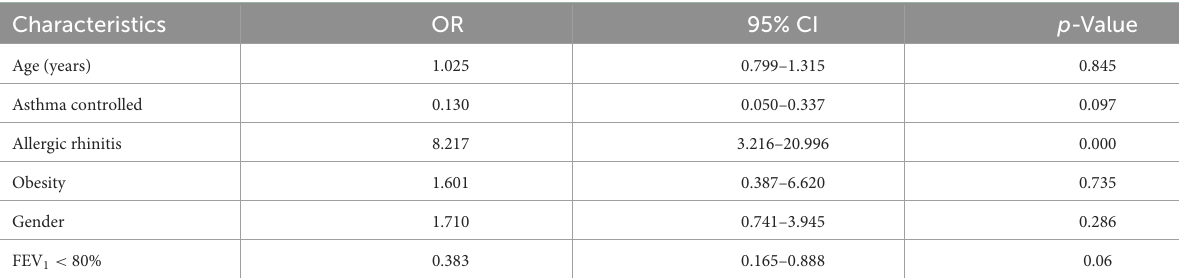
TABLE 4 Odds ratio of OSA for asthmatic children.